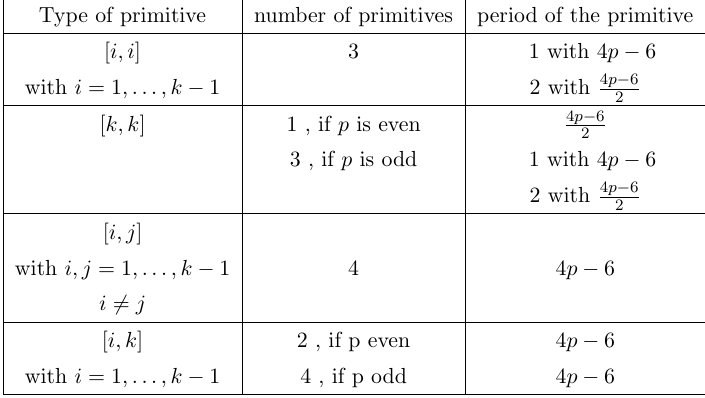
Table 1 . Primitive graphs of type